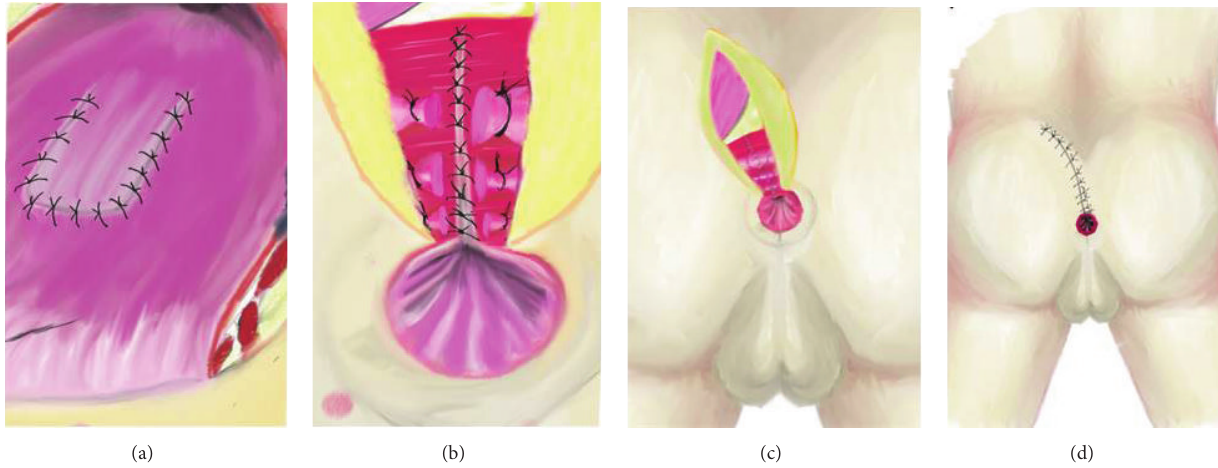
Figure 8: Schematic illustration of the picture in Figure 7 showing closure of posterior rectal wall and anal sphincter in an anatomical plane. (a) Closed RUF with rectal flap is seen. (b) Closed posterior rectal wall is seen. (c) Separately repaired anal sphincters by the guidance of suture which was placed at the beginning of operation. (d) Closed skin incision of the York Mason operation is